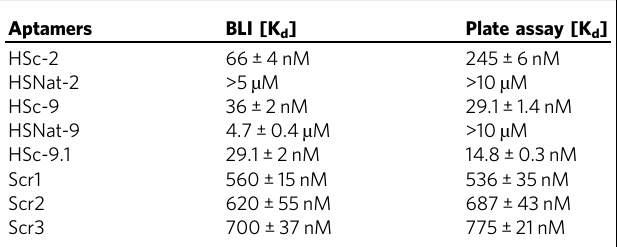
Table 6 Binding af fi nities of aptamers and their scrambled alternatives with